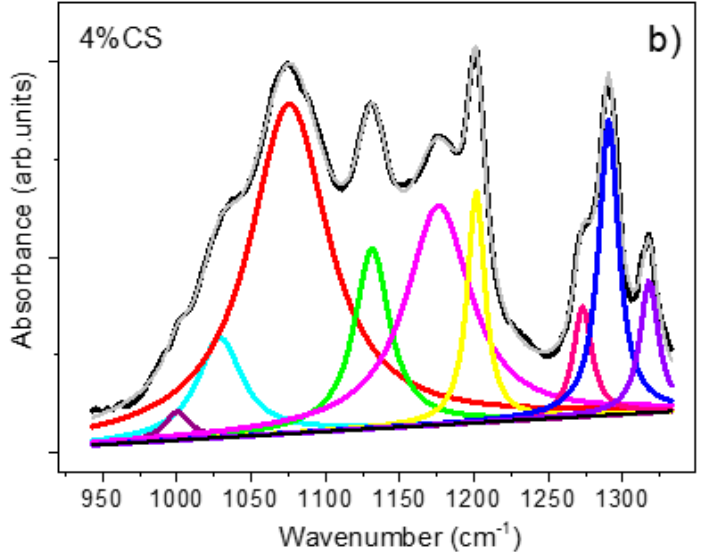
Figure 7. Fitting of FTIR spectra in the region 900–1350 cm − 1 for ( a ) sample A (0%CS/%PVP) and ( b ) sample E (4%CS/6%PVP): the black line corresponds to the experimental spectrum, the grey line corresponds to the fitting envelope and the colour lines correspond to different contribution bands.